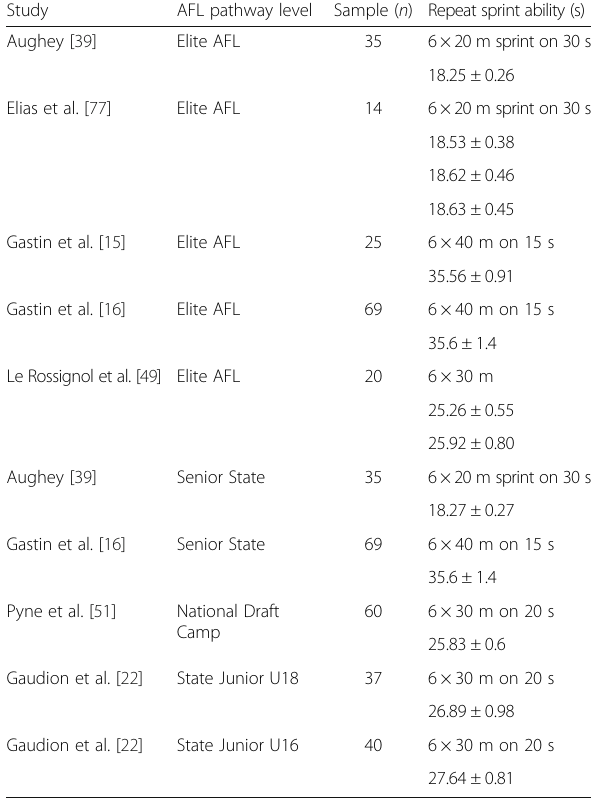
Table 3 Repeat sprint performance measures reported for level of AFL participation pathway. Measures represented as mean ± standard